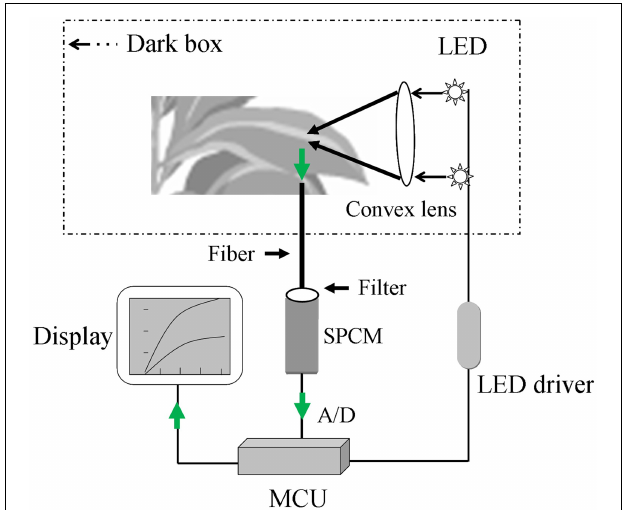
FIGURE 1 | A sketch of the custom-made sensor for detecting dichlorofluorescein (DCF) fluorescence. The sensor is mainly composed of the following parts: sample chamber (dark box), excitation light source (light-emitting diode, LED), single photon counting module (SPCM), display system, and data acquisition and processing system (micro control unit, MCU). The green arrow represents the collection process for the DCF fluorescence